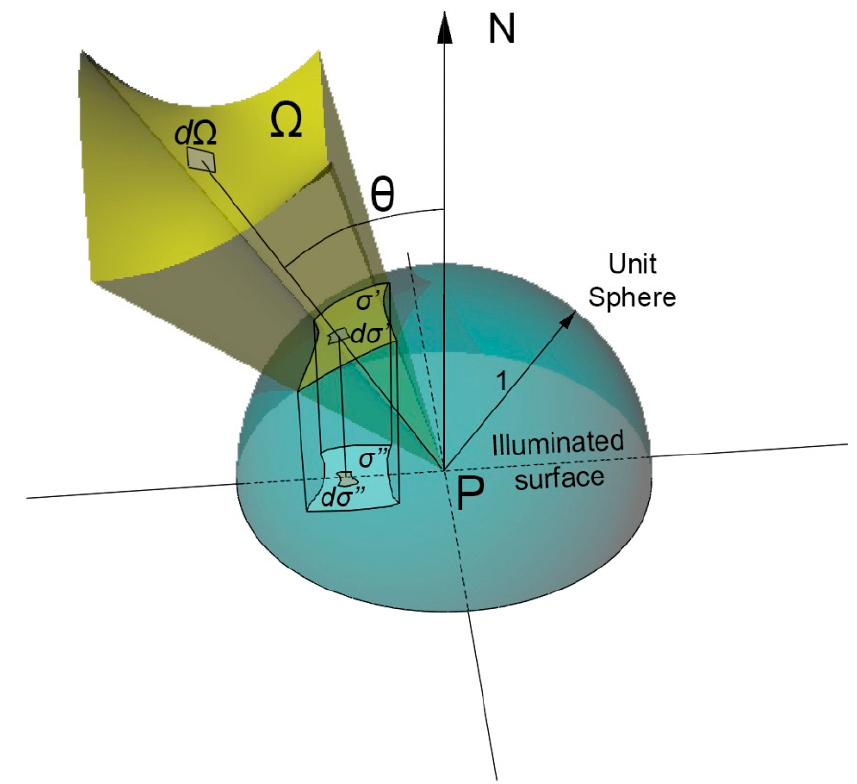
Figure 5. The cone of radiation of this figure cuts the area σ ’ on the unit sphere. The orthogonal projection of σ ’ over the irradiated plane produces the area σ ’’. Such area divided by π r 2 (r = 1) equates to the configuration factor.